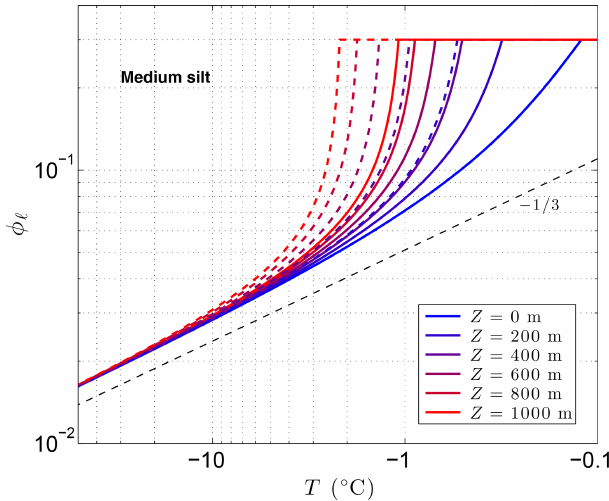
Figure 4. Sensitivity of the volume fraction of liquid water φ (cid:96) to depth below surface z . Solid lines are for hydrostatic pore pressures, while dashed lines are for lithostatic pressures. In this example, the solute (NaCl) concentration is x (cid:63) s = 0 . 001, r = 15µm, φ = 0 . 3, and λ = 0 . 36µmK 1 / 3